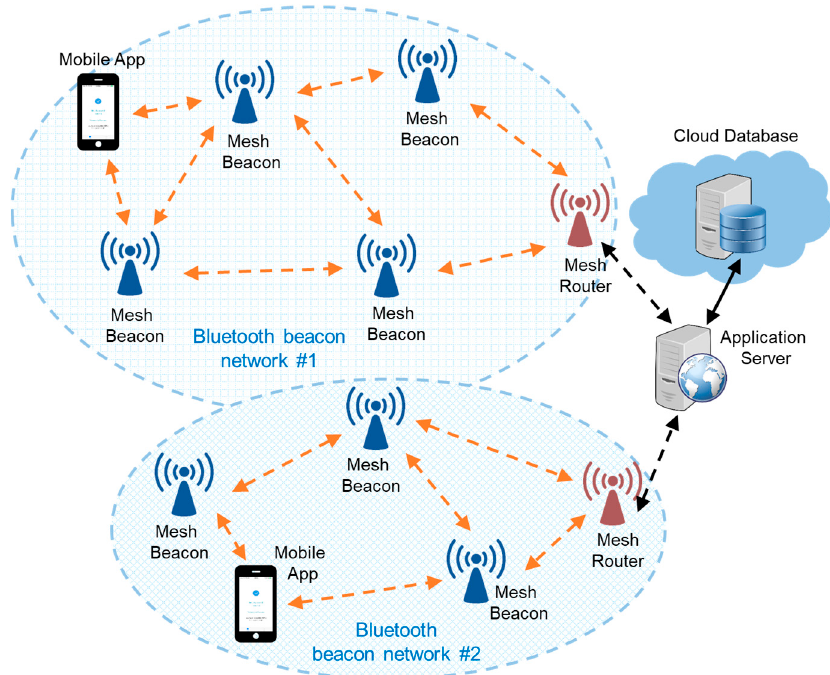
Figure 1. System architecture.